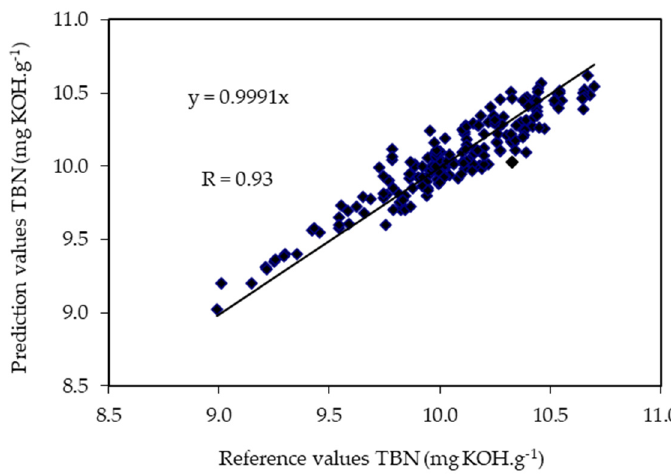
Figure 2. Regression dependency between values of TBN predicted by an FTIR-PLS model and values determined by a standardized ˇCSN ISO 3771 method.